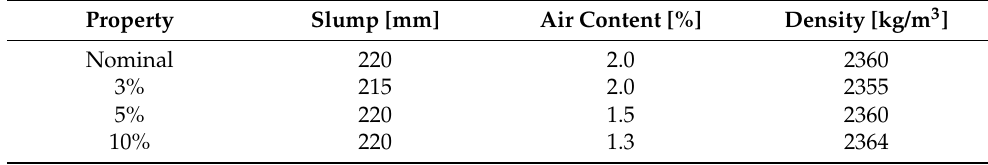
Table 3. Results of fresh concrete